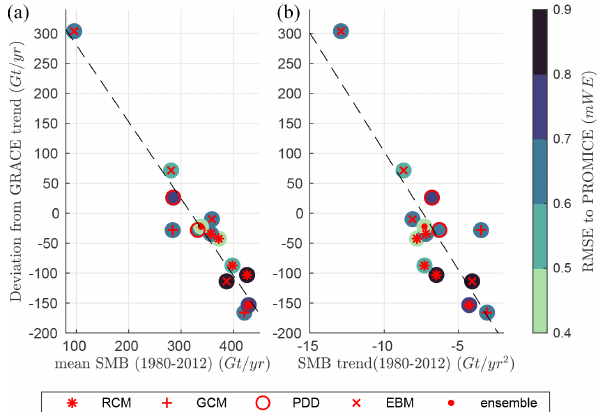
Figure 7. (a) Scatter plots of the deviation from GRACE trend (in GTyr − 1 ) vs. mean SMB over 1980–2012 (in GTyr − 1 ), listed in Table 4 and Table 2, respectively. (b) Same as left but with the SMB trend over 1980–2012 (in GTyr − 2 ). In both plots, the background colour indicates the RMSE with the PROMICE SMB database (see Table